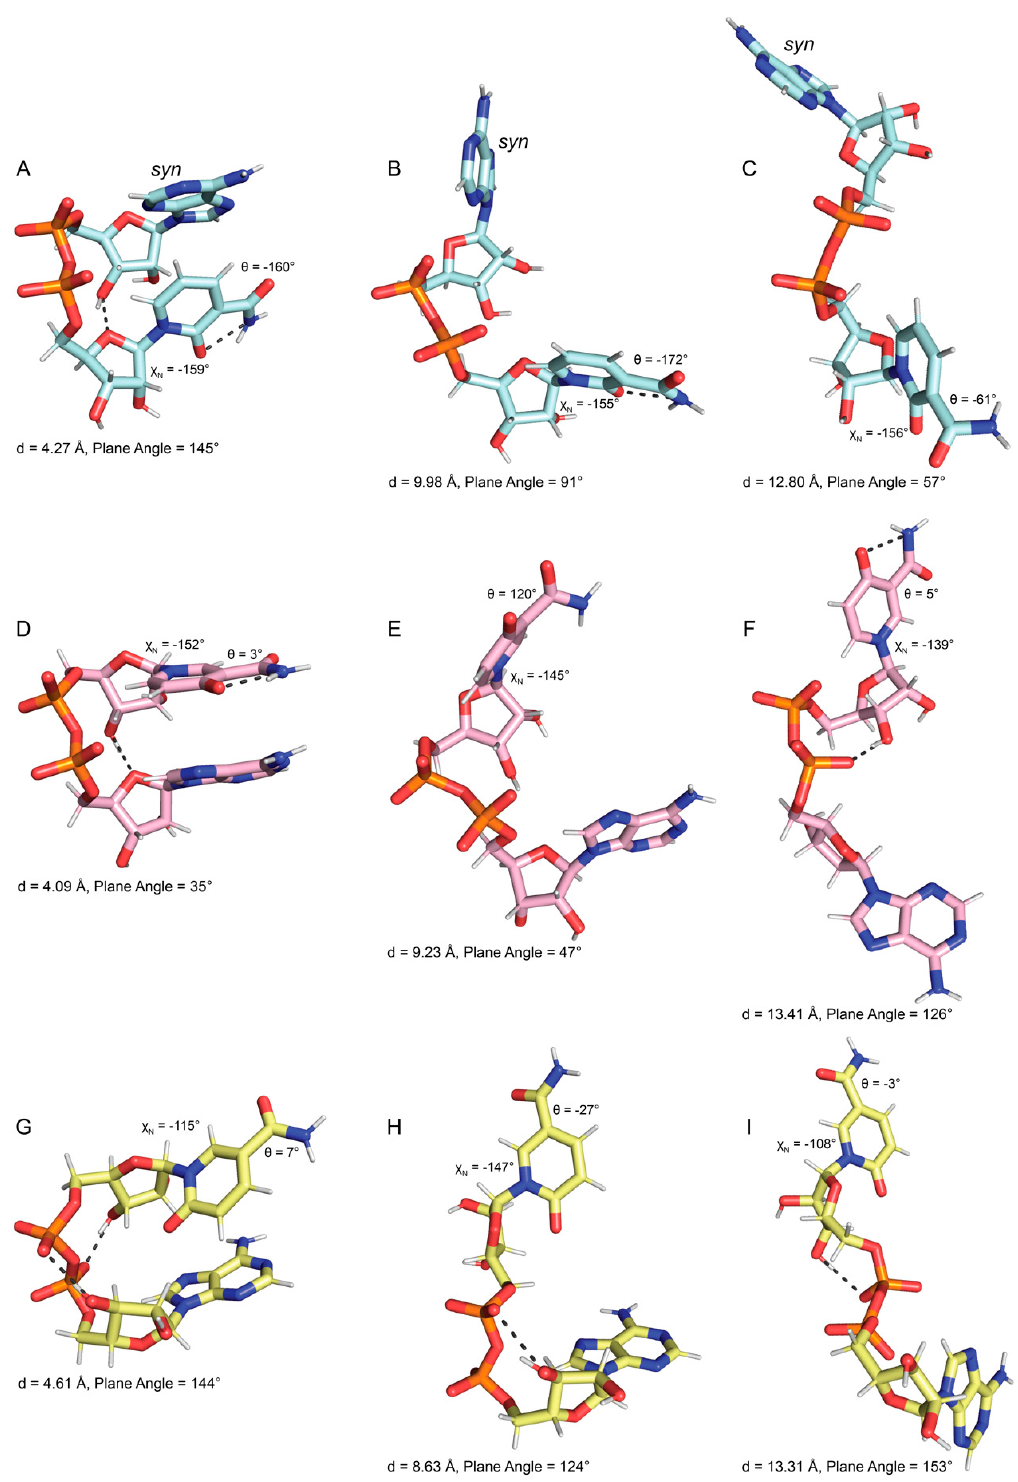
Figure 6. Examples of the most common conformations of ox-NADs. ( A – C ) Folded, semi-extended, and extended conformations of 2-ox-NAD (cyan). ( D – F ) Folded, semi-extended, and extended conformations of 4-ox-NAD (pink). ( G – I ) Folded, semi-extended, and extended conformations of 6-ox-NAD (yellow). Values of the inter-base centroid distance “d”, plane angle, θ , and χ N are indicated for each pose. Hydrogen bonds are indicated by dashed black lines between heavy atoms. All the glycosidic bonds have anti conformations except as noted for adenosine in panels A, B, and C. Cluster representations of these conformations are provided in Supplementary Figure